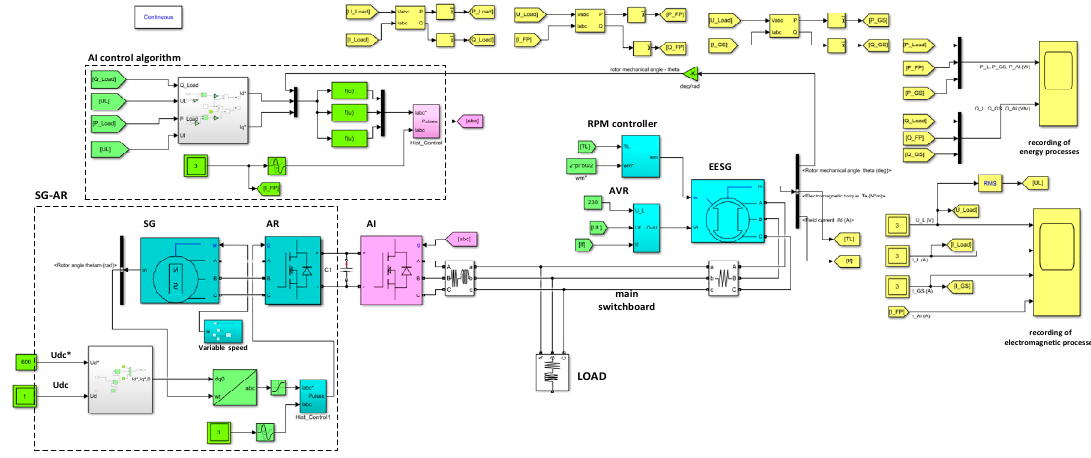
Figure 14. Simulation model of a stand-alone hybrid ship power plant system with parallel operation of an DG and SG.